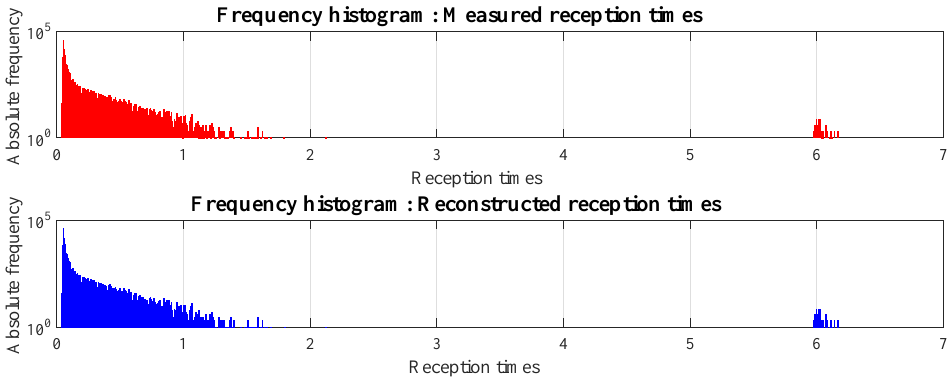
Figure 20. Measured and reconstructed reception times frequency histogram (using log scale on x - and y -axis).